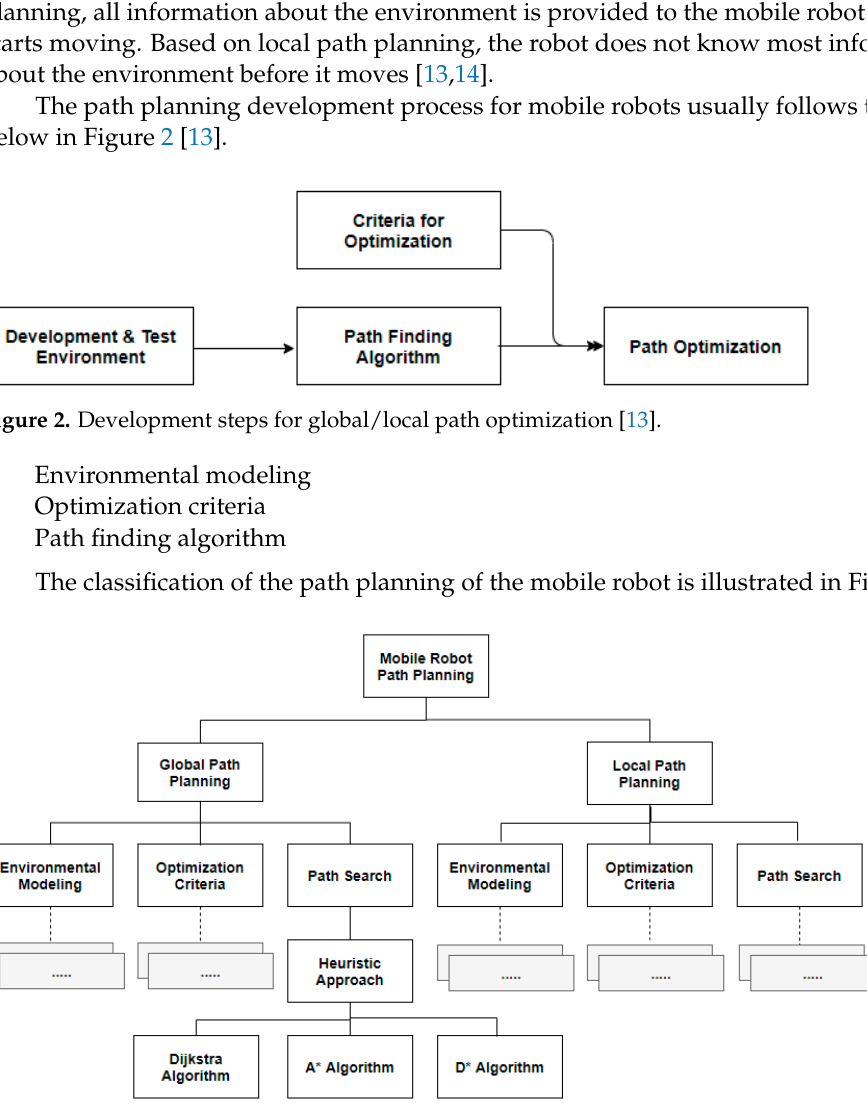
Figure 3. Classification of path planning and global path search algorithm [13].